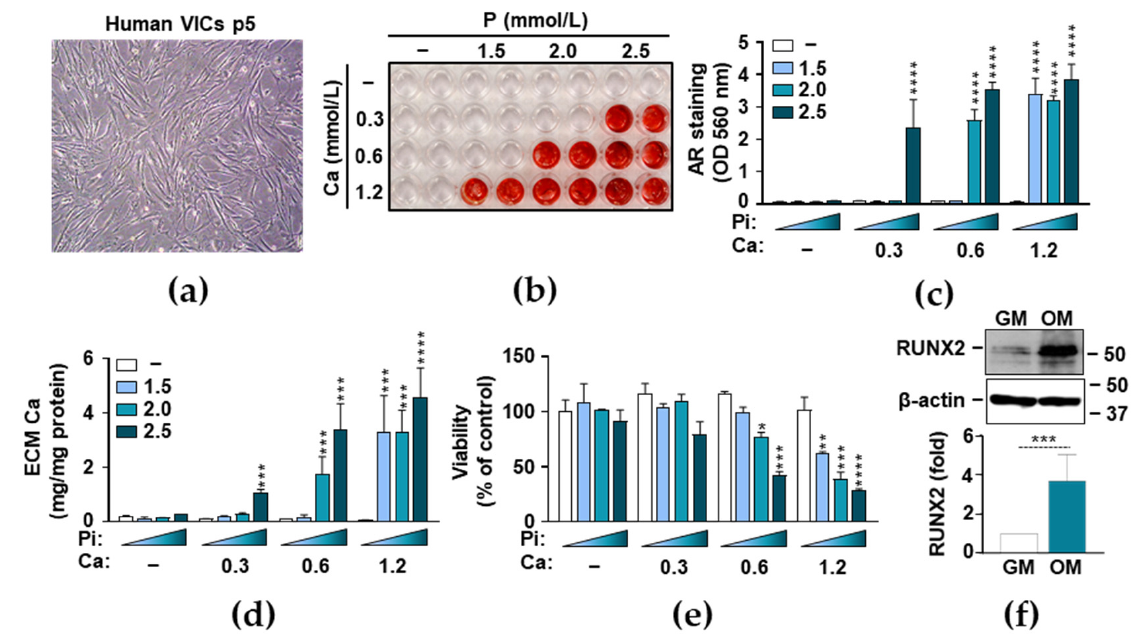
Figure 1. Osteogenic stimuli induce extracellular matrix mineralization and Ca deposition of valve interstitial cells (VICs). ( a – f ) Confluent VICs (passage number 5–8) were maintained in growth medium (GM) or in osteogenic medium (OM) obtained by supplementing growth medium (GM) with phosphate (P) (0–2.5 mmol/L) and Ca (0–1.2 mmol/L). ( a ) Bright- field microscope image of human VICs in passage number 5, 100 × magnification. ( b , c ) Ca deposition in the extracellular matrix (ECM) was evaluated by Alizarin Red (AR) staining after 7 days of treatment. Representative images of stained plates from three independent experiments and quantification are shown. ( d ) Ca content of the HCl-solubilized ECM is presented. ( e ) Cell viability was determined by MTT assay after 7 days of treatment. ( f ) Protein expression of RUNX2 was determined from whole cell lysates (24 h). Membranes were reprobed for β -actin. Representative Western blots and relative expression of RUNX2 normalized to β -actin from three independent experiments are shown. Results are presented as mean ± SD of three independent experiments performed in triplicate. * p < 0.05, ** p < 0.01, *** p < 0.005, **** p <